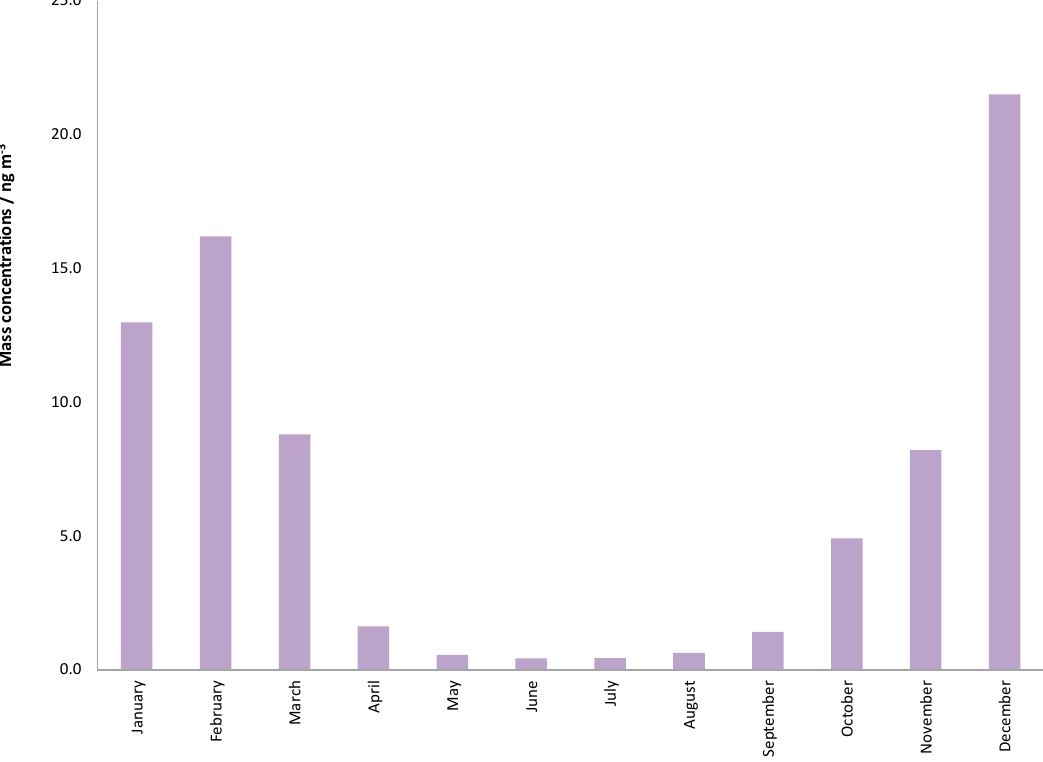
Figure 2. Monthly mass concentrations of Σ PAHs (polycyclic aromatic hydrocarbons) measured during one calendar year.